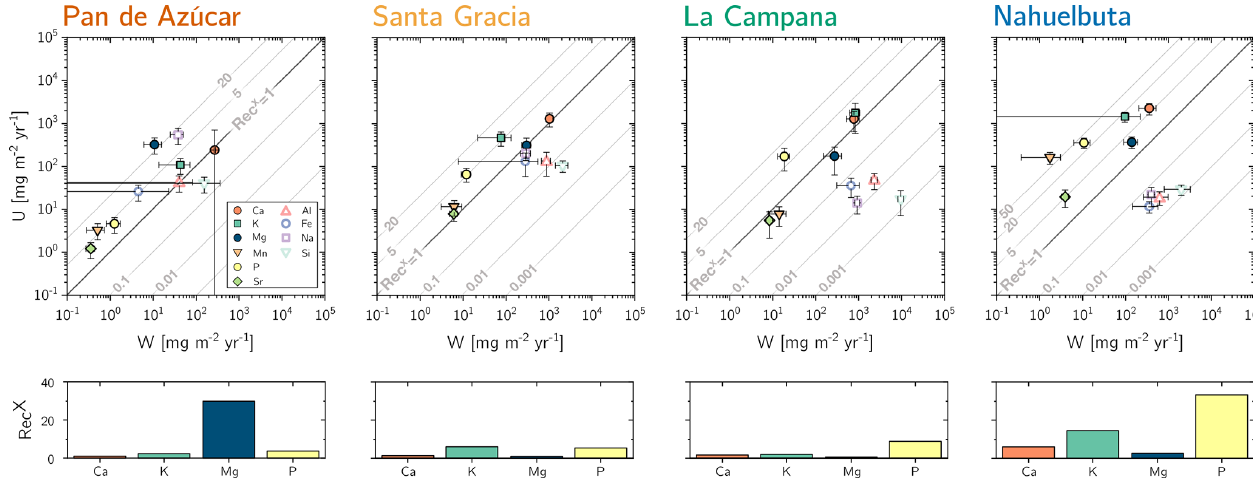
Figure A4. Chemical weathering flux ( W X ) and ecosystem nutrient-uptake fluxes ( U X ) for Pan de Azùcar, Santa Gracia, La Campana, regolith total and Nahuelbuta (from left to right). Weathering–release fluxes for Ca, K, Mg, Na, and Sr in Pan de Azúcar have been complemented by atmospheric depositional fluxes such that the total amount of available nutrients increases by 95%, 22%, 18%, 12%, and 10%, respectively. Grey contour lines emphasize the nutrient recycling factor (Rec X ), which is the ratio of U X to W X . Uncertainty bars show 1SD. total regolith Differences in nutrient recycling factors for Ca, K, Mg, and P among the four study sites are highlighted in the lower panels.